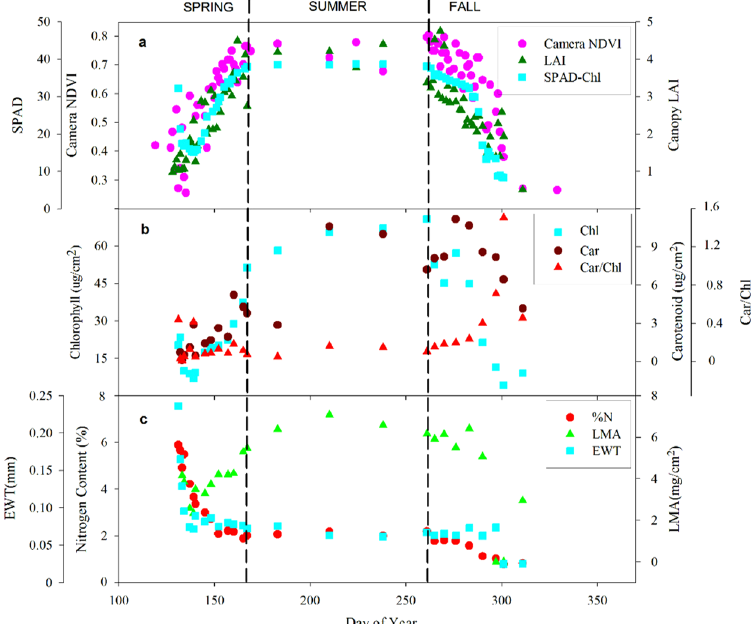
Figure 1. Seasonal changes of phenological metrics and leaf physiological properties. ( a ) Camera-NDVI, leaf area index (LAI) measured by LAI-2000 and leaf chlorophyll concentration measured by SPAD; ( b ) leaf total chlorophyll and carotenoids concentration, and their ratio (Car/Chl); ( c ) Leaf nitrogen content (%N), leaf mass per area (LMA) and Equivalent Water Thickness (EWT). The black dashed lines are the season dividers according to the seasonality of